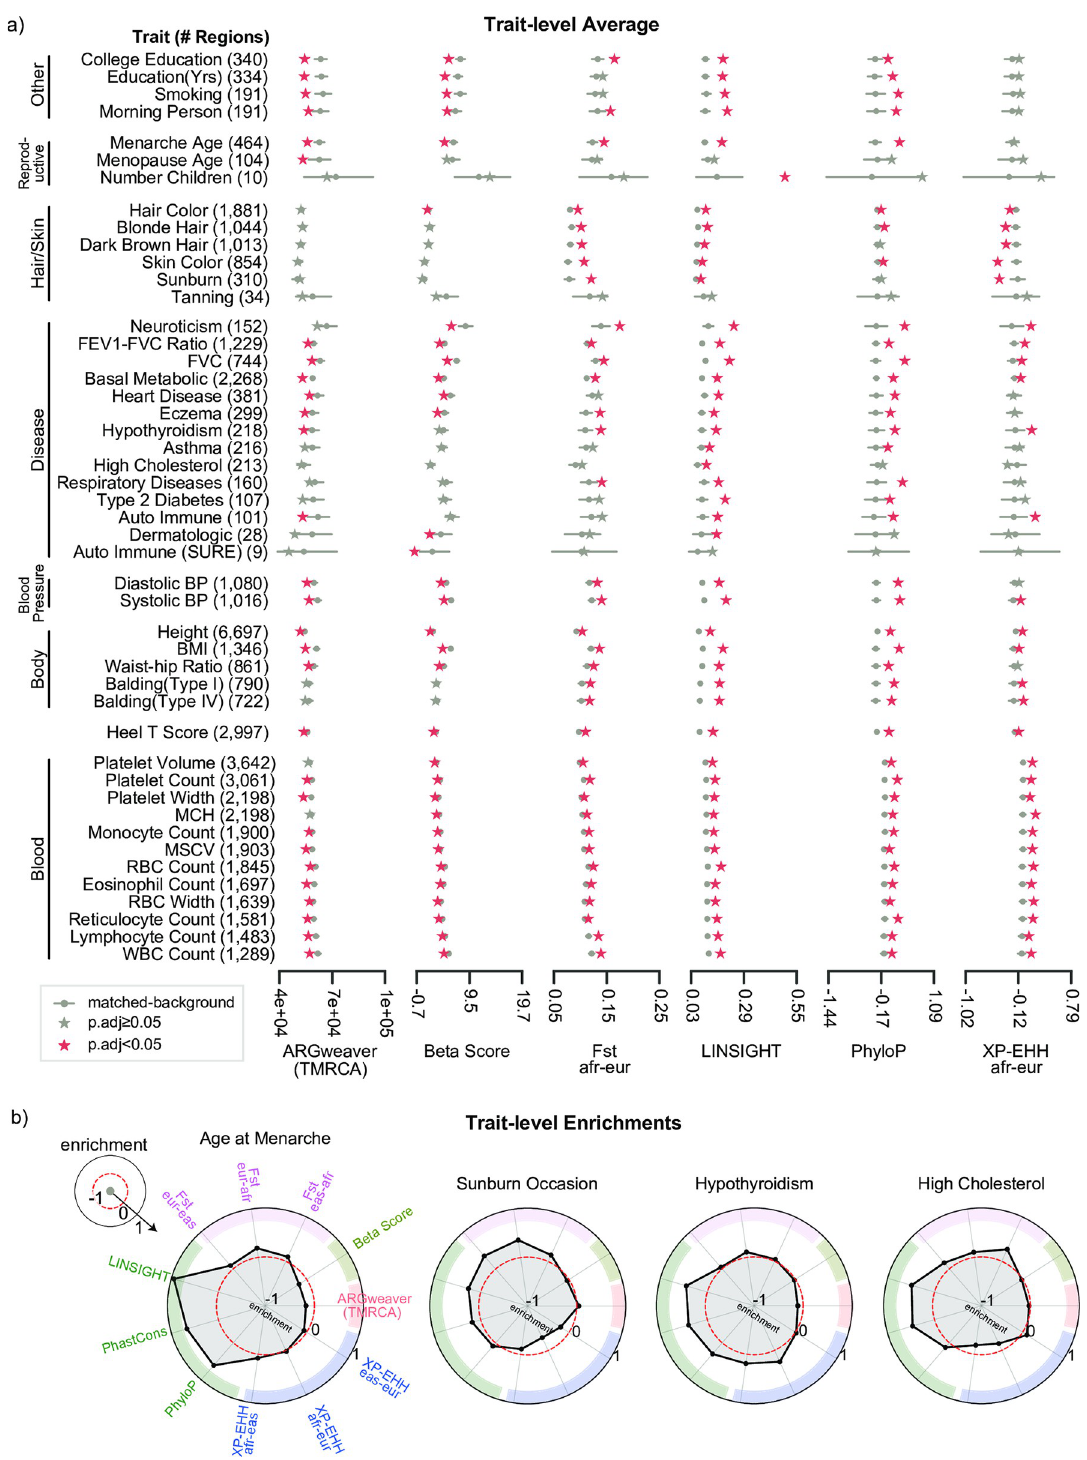
Fig 3. Mosaic evolutionary architecture across 47 well-powered GWASs of human complex traits. From our evolutionary atlas of 972 GWASs, we plot a subset of 47 GWASs (BOLT-LMM set) performed using the same approach and from the same cohort (Methods). (a) For each evolutionary measure (columns) and a given trait (row), we calculated the trait-averaged value (x-axis, stars) and compared it with the matched genomic background distribution (gray dots: mean values, gray bars: 5th, 95th percentiles). Traits are manually grouped based on type and similarity. The number of trait-associated regions is provided in parentheses. Red